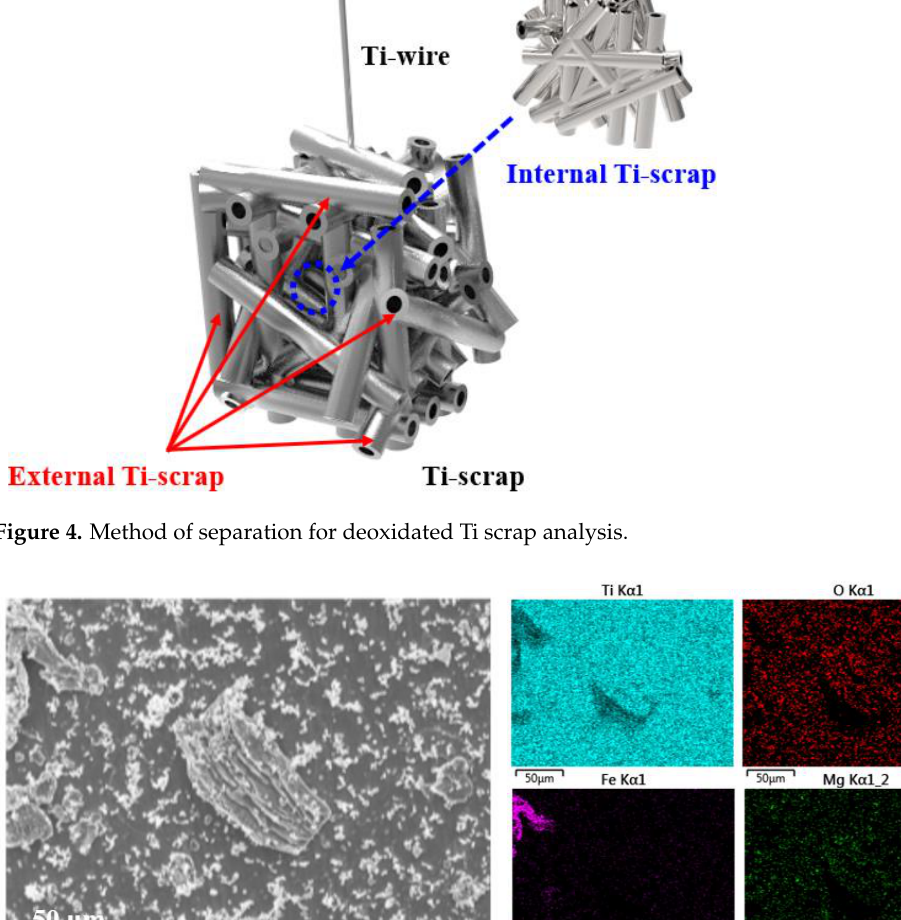
Figure 4. Method of separation for deoxidated Ti scrap analysis.